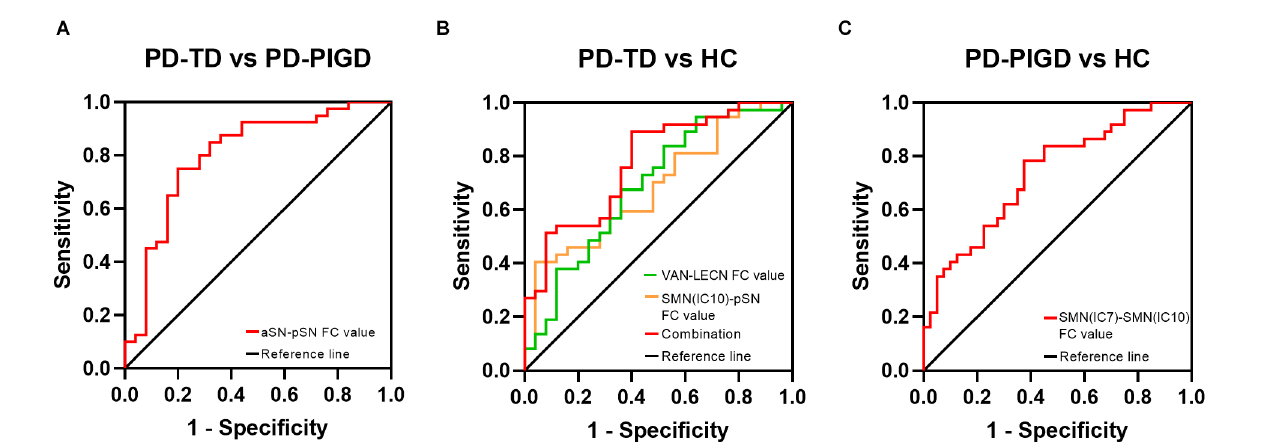
FIGURE4 Receiver operating characteristic (ROC) curves for predicting PD-TD and PD-PIGD patients by neuroimaging biomarkers of internetwork connectivity. (A) ROC curve showing the classification of TD and PIGD. (B) ROC curve showing the classification of TD and HCs. (C) ROC curve showing the classification of PIGD and